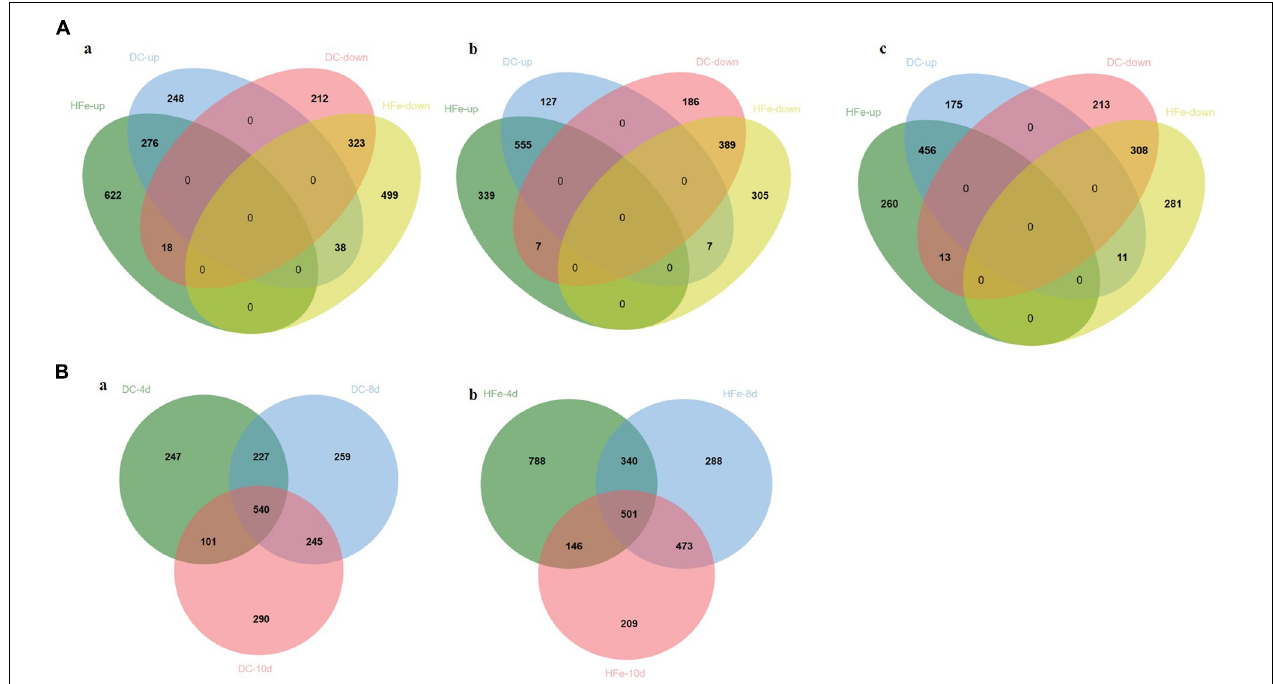
FIGURE 3 | Number of common and specific significantly differentially expressed proteins in DC3000 with the addition of 20 µ mol/L FeCl 3 (DC) and 400 µ mol/L FeCl 3 (HFe) compared to the control group with no addition of FeCl 3 (0Fe). (A) Venn diagrams showing upregulated and downregulated proteins between three time points, respectively, which are (a) 4 days after inoculation, (b) 8 days after inoculation, and (c) 10 days after inoculation. (B) Venn diagrams showing unique and shared upregulated and downregulated proteins between three time points, which are (a) 20 µ mol/L FeCl 3 (DC) compared to the control group (b) 400 µ mol/L FeCl 3 (HFe) compared to the control group, quantified in all three biological replicates with fold change > 2 or < 0.5 in quantity ( p < 0.05). Venn analysis used the VennDiagram package (R, Version 1.6.20).